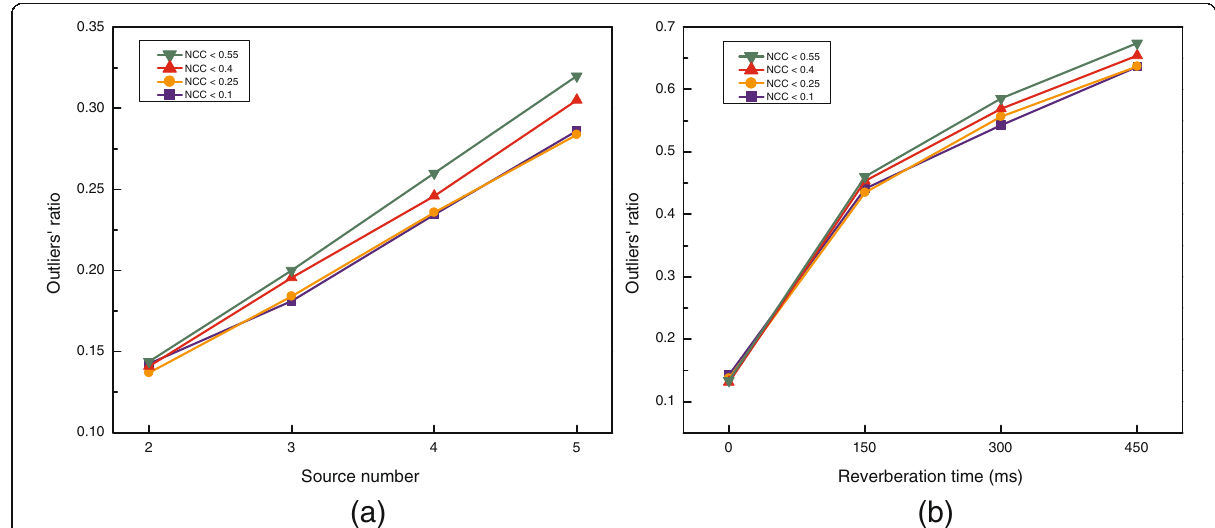
Fig. 1 Statistical analysis for outliers ’ ratio in different conditions. a Different source number in anechoic room ( b ) two sources with different reverberation